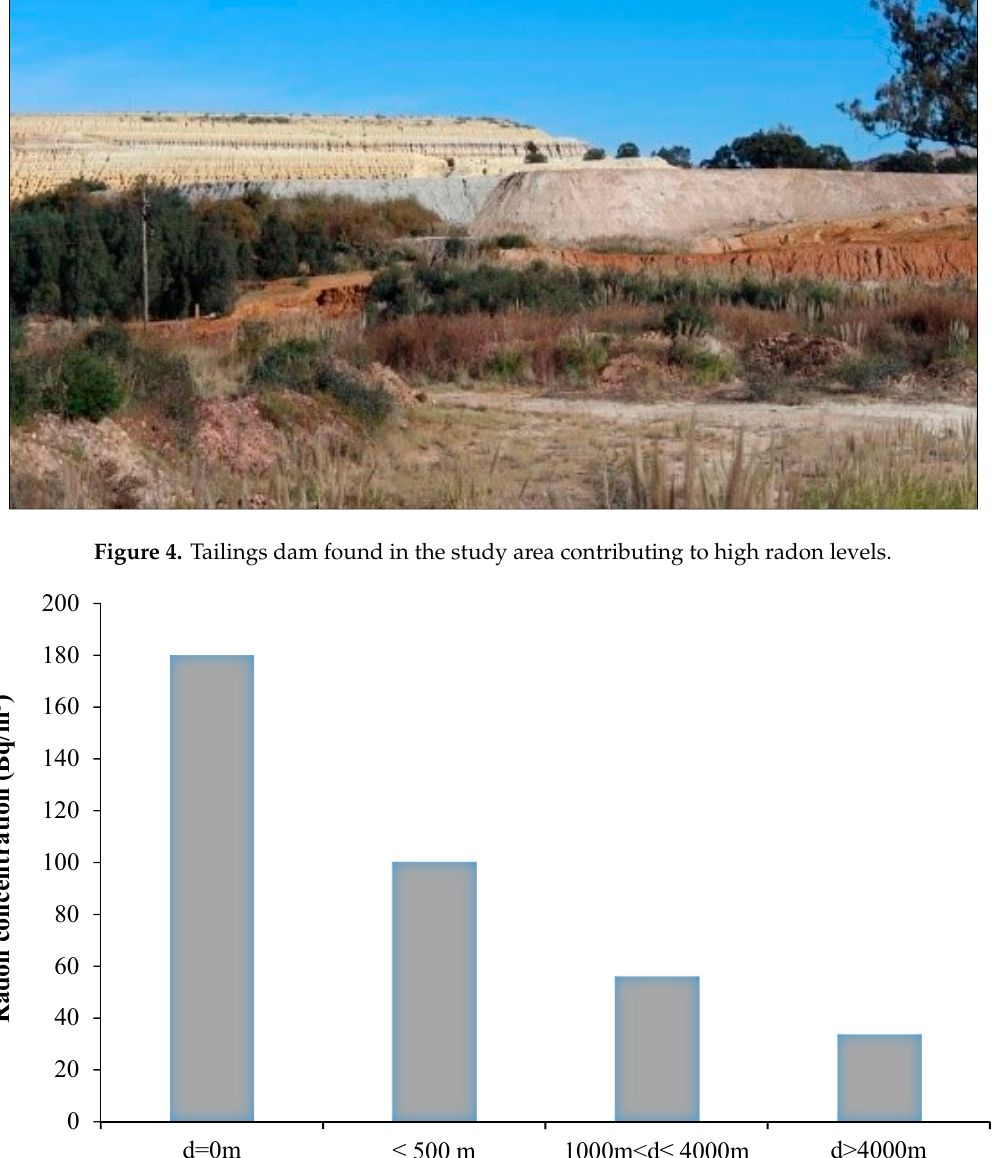
Figure 5. Average radon concentration as a function of distance from the closest tailings residues (where d = 0 m is the location of the tailings dominated region).